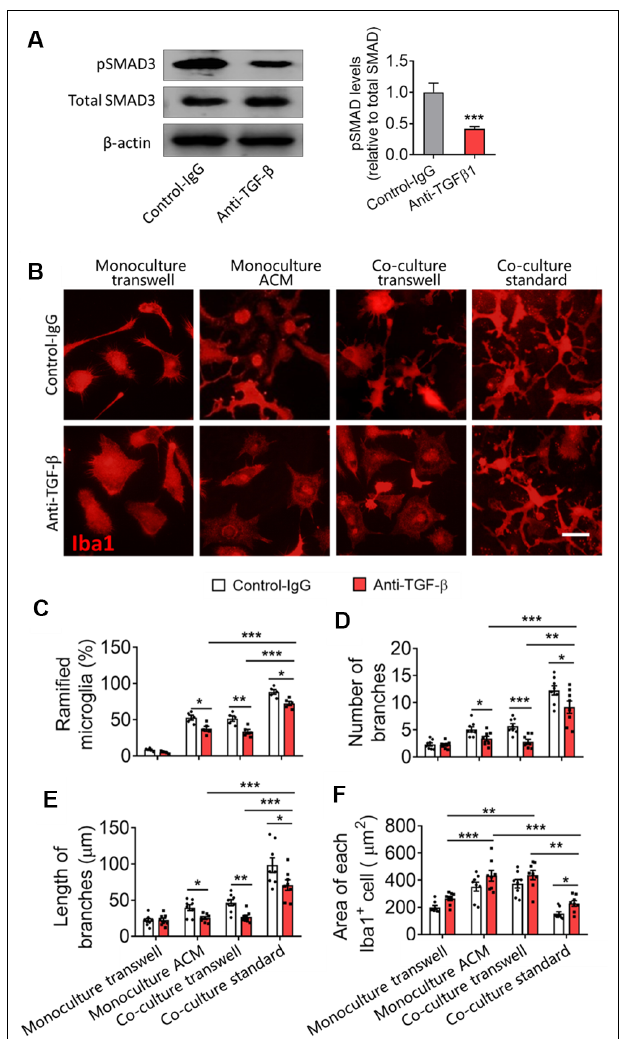
FIGURE 7 | Astrocytes produce TGF- β that contributes to microglial ramification. (A) Western blotting showing changes in pSMAD3 in microglia cultured by ACM with or without anti-TGF- β antibody. (B) Fluorescence micrographs showing differences in microglial morphology with or without anti-TGF- β antibody. Microglia were labeled by Iba1 (red). Scale bar, 10 µ m. (C–F) Percentage of ramified microglia (B), number (C) and length (D) of branches, and cell body area of microglia (E) . Results of each group were obtained from eight independent samples, and 4–5 micrographs were collected for each sample. All Iba1 + cells in each micrograph were measured. Each dot in the bar graph represents the average of each simple. Data are presented as mean ± SEM, * P < 0.05, ** P < 0.01, and *** P < 0.005 ( n = 8, unpaired two-tailed Student’s t -tests or two-way ANOVAs, followed by Tukey’s multiple-comparison test, where